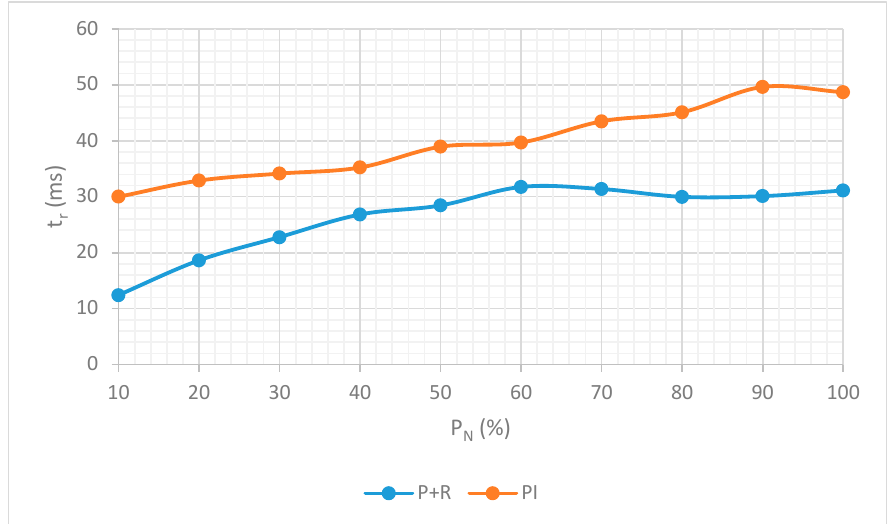
Figure 19. Comparison of adjustment times of P+R and PI controllers in the tested system for startup with the set active component.